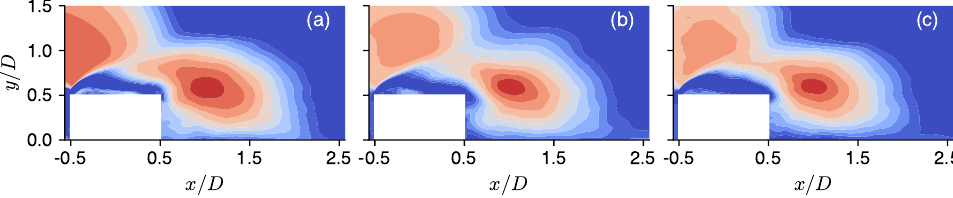
Figure 6. Two-point correlation of streamwise velocity. The reference point is at x / D = 1.0, y / D = 0.6. ( a ) smooth inflow, and turbulent inflows with ( b ) ILS = 1.0 D , TI = 0.04, and ( c ) ILS = 0.2 D , TI = 0.10. Contours starts from 0 (in dark blue) to 1 (in dark red) with an increment 0.1.